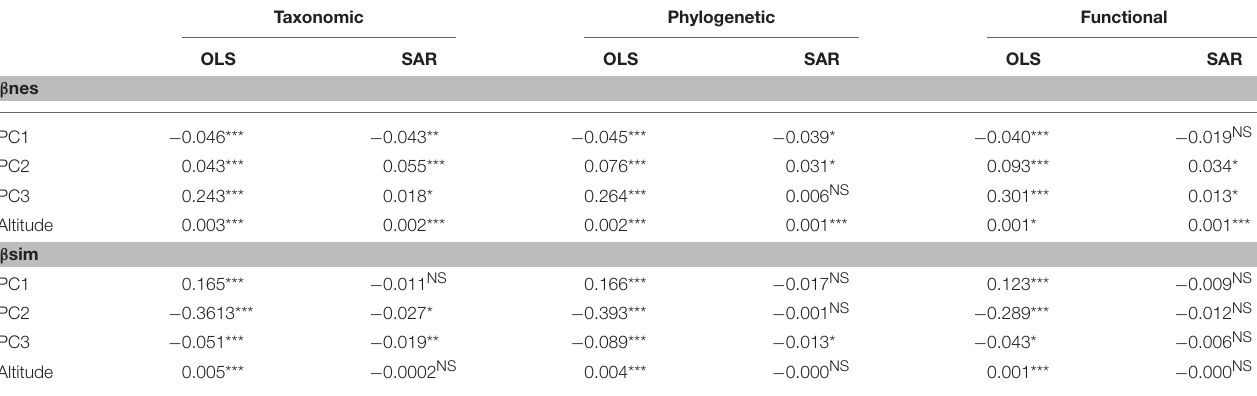
TABLE 2 | Standardized coefficients of environmental effects on beta diversity